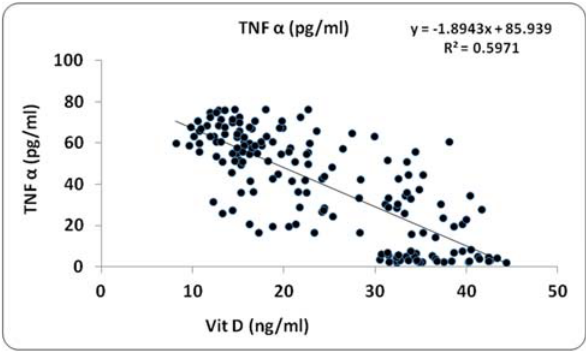
Figure 2: Scatter plot with regression line between vitamin D and TNF - α .